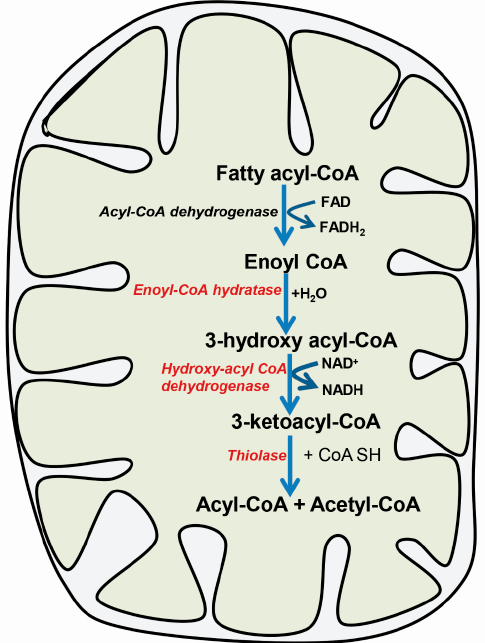
Figure 1. Mitochondrial fatty acid β -oxidation pathway. Classical β -oxidation pathway involves dehydrogenase by acyl-CoA dehydrogenase and hydration, dehydrogenation and thiolyic cleavage is catalyzed by the mitochondrial trifunctional protein (MTP, highlighted in red color). MTP consists of enoyl-CoA hydratase, hydroxy acyl-CoA dehydrogenase and thiolase activity. The straight arrows represent products and bent arrows represent the involvement of co-factor in this enzyme catalyzed